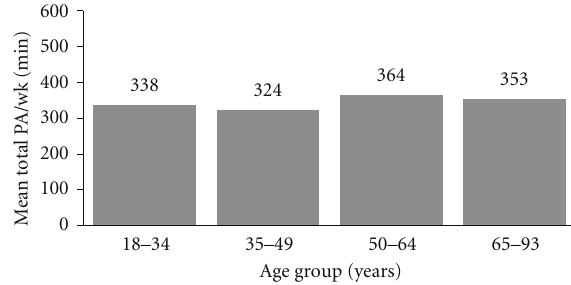
Figure 2: Self-reported mean moderate and vigorous physical activity, according to age group. One-way ANOVA P value across age groups = 0.07.